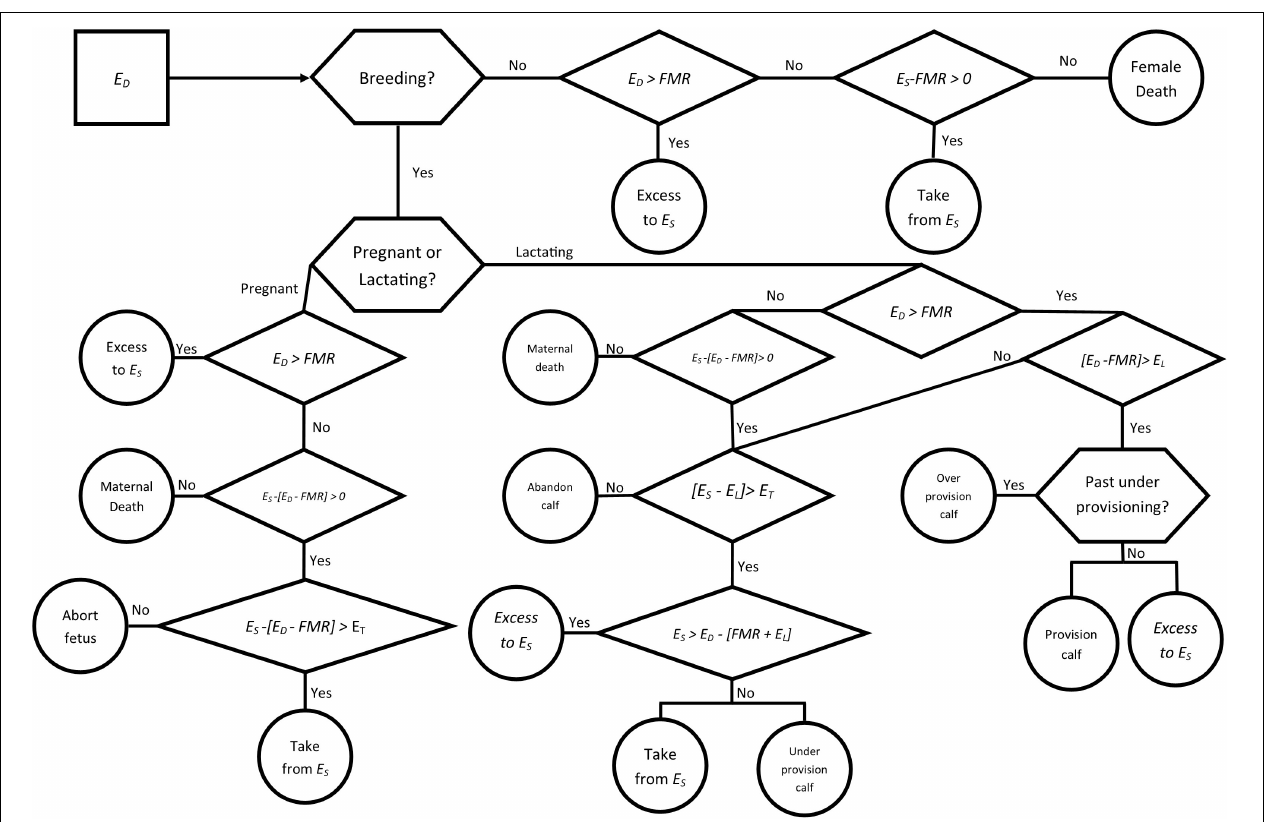
FIGURE 2 | Decision tree representing a single time step (1 day) in the model for an adult female bottlenose dolphin. Ingested energy ( E D ) is acquired by an individual each day, the use of that energy varies depending on the reproductive status of the female.